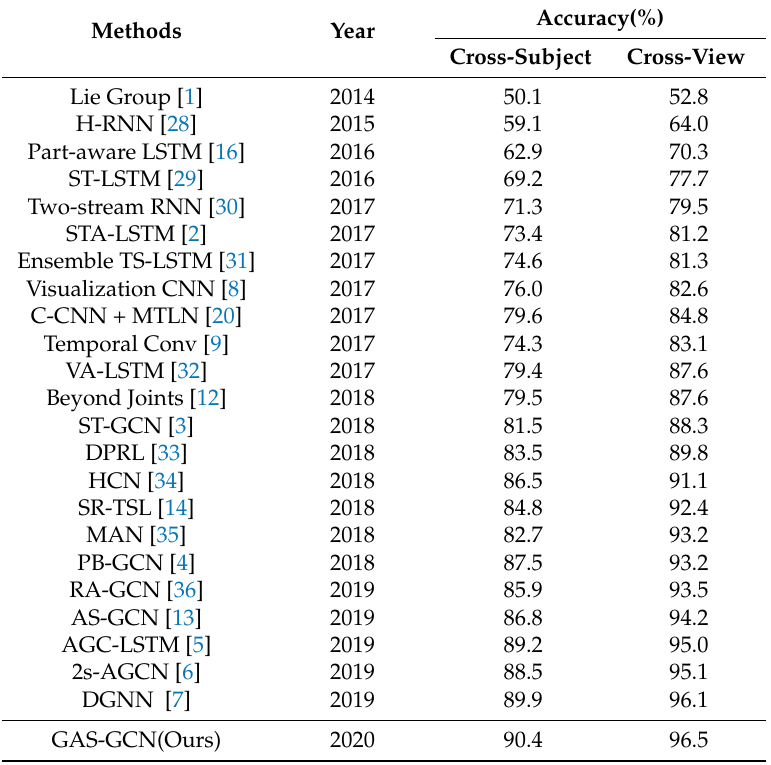
Table 1. Comparison with the state-of-the-art methods on NTU-RGB + D dataset.